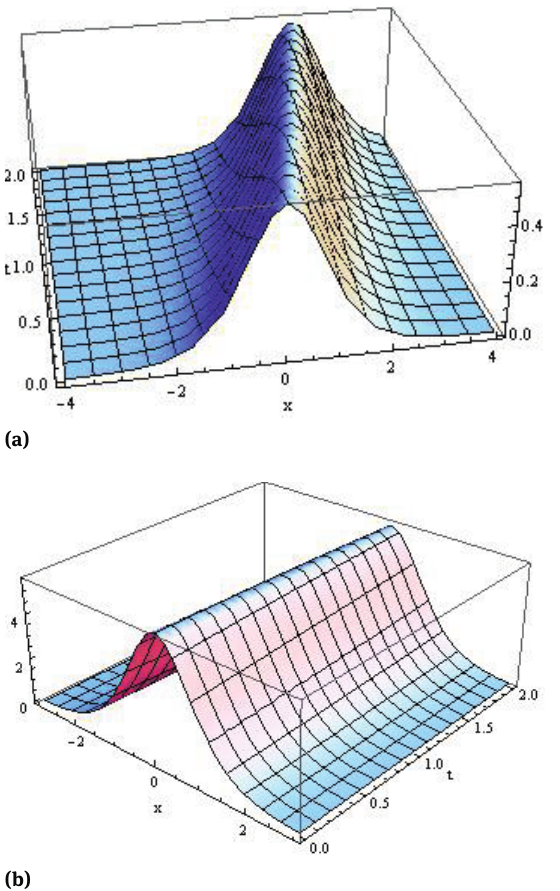
and successful technique to get the solitary solutions for the system of K-G-Z